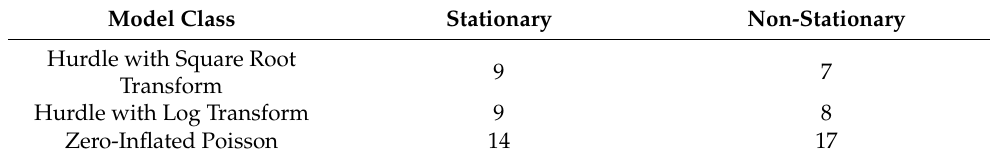
Table A3 lists the number of model classes for all users in the ROBAS 2 study that we obtained after the procedure was run. Table A3. Number of selected model classes for the Stationary and Non-Stationary